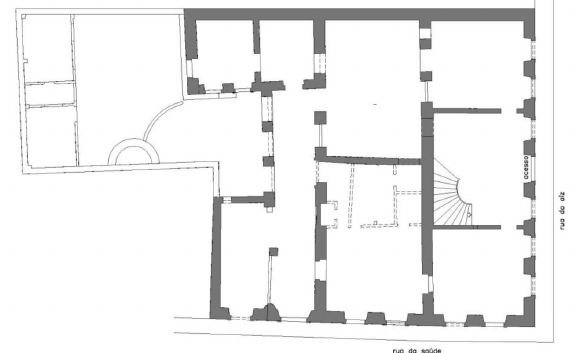
Figure 11. Original plan configuration for the case study Sobrado.